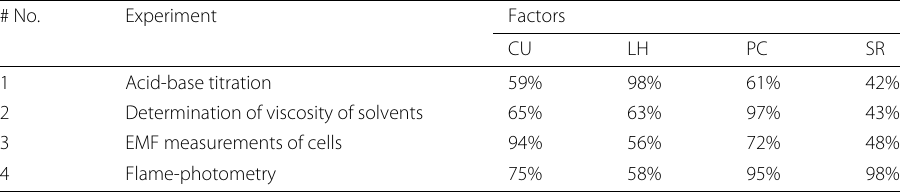
Table 1 Factors impacting experimental self-efficacy in physical laboratories # No. Experiment